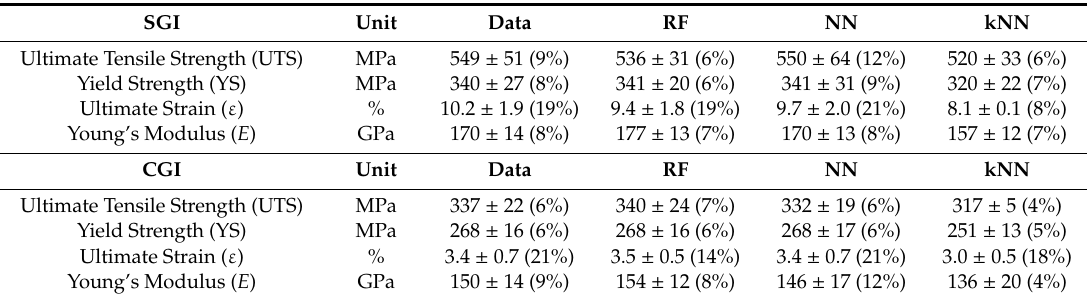
Table 6. Mechanical properties prediction in terms of mean values and standard